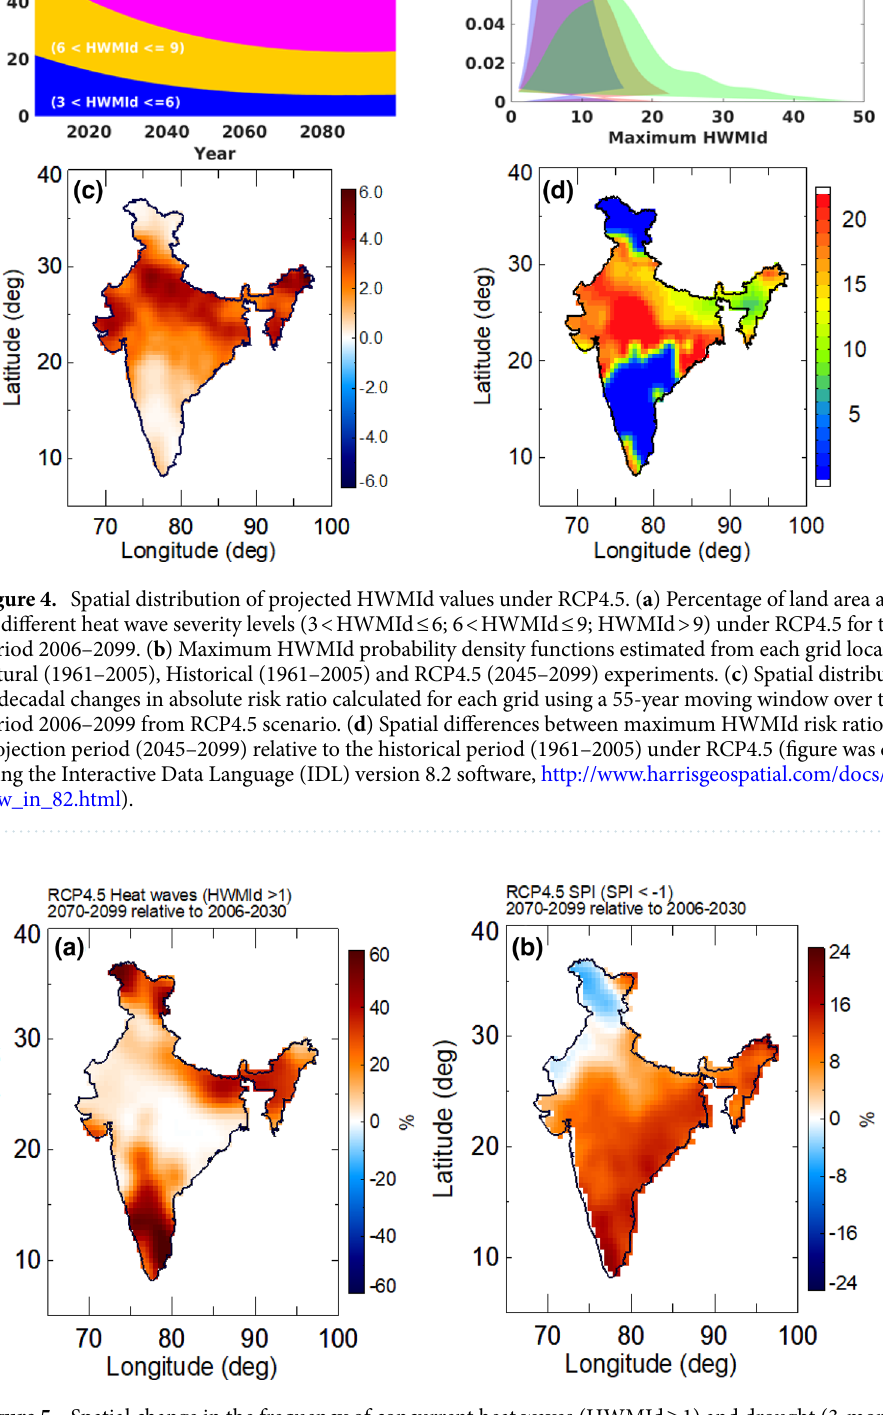
Figure 5. Spatial change in the frequency of concurrent heat waves (HWMId ≥ 1) and drought (3-month SPI ≤ − 1) under RCP4.5 during 2070–2099 relative to 2006–2030. ( a ) Heat waves occurring one month after drought. ( b ) Heat waves occurring simultaneously with drought (figure was created using the Interactive Data Language (IDL) version 8.2 software, http:// www. harri sgeos patial. com/ docs/ whats_ new_ in_ 82.